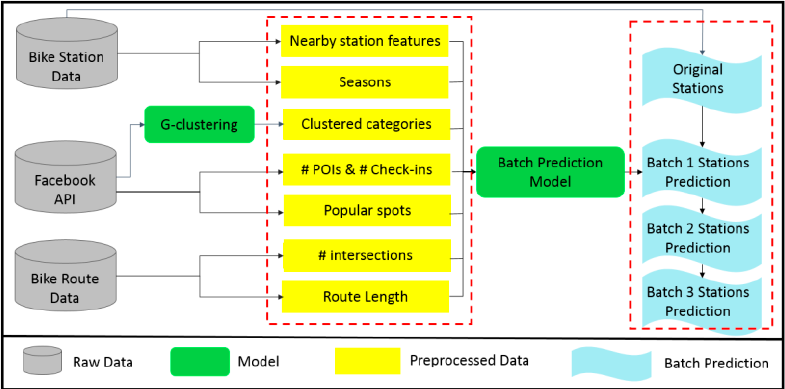
Figure 1. The overview of LDA Framework.